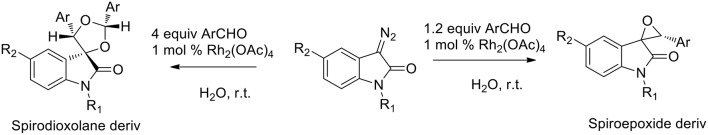
Schematic representation of spiro-indole synthesis from 3-diazooxindole derivatives.